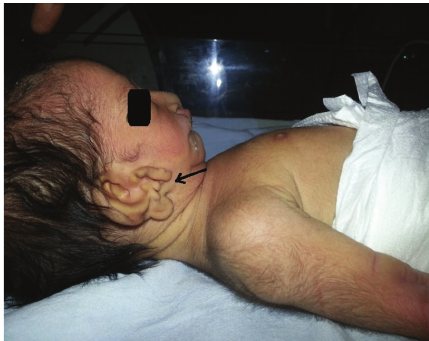
Figure 1: Right ear accessory tags. Right stenosed EAC. Hypoplasia of right malar region. Micrognathia.